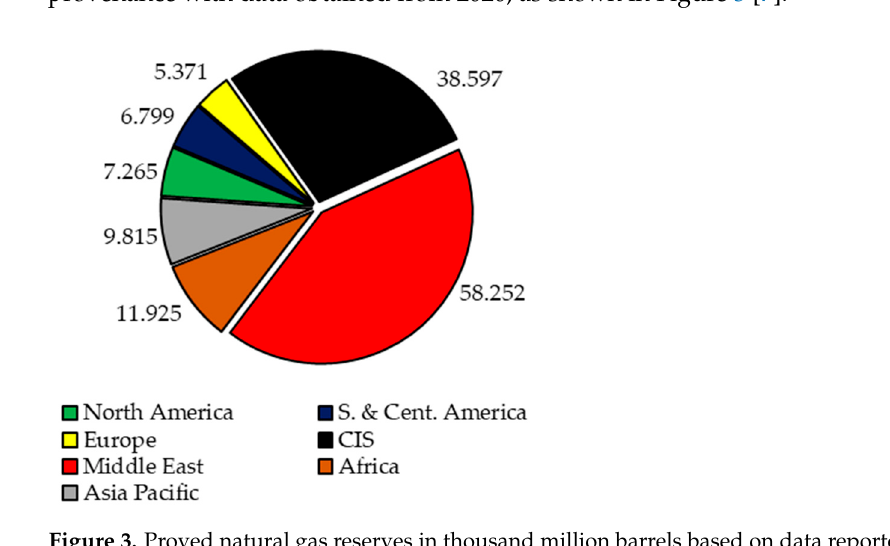
Figure 4. Hydrogen production process by methane cracking. Figure 3. Proved natural gas reserves in thousand million barrels based on data reported by BP,